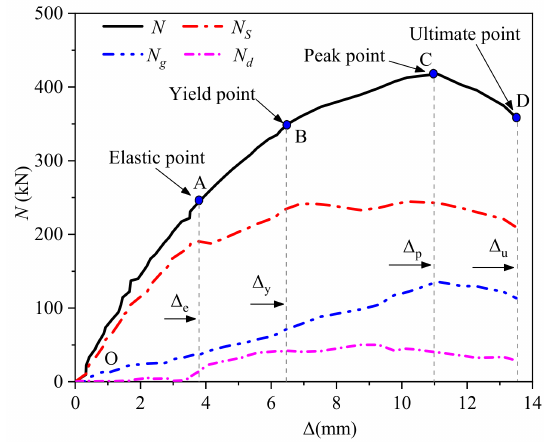
Figure 13. Internal force analysis during loading.